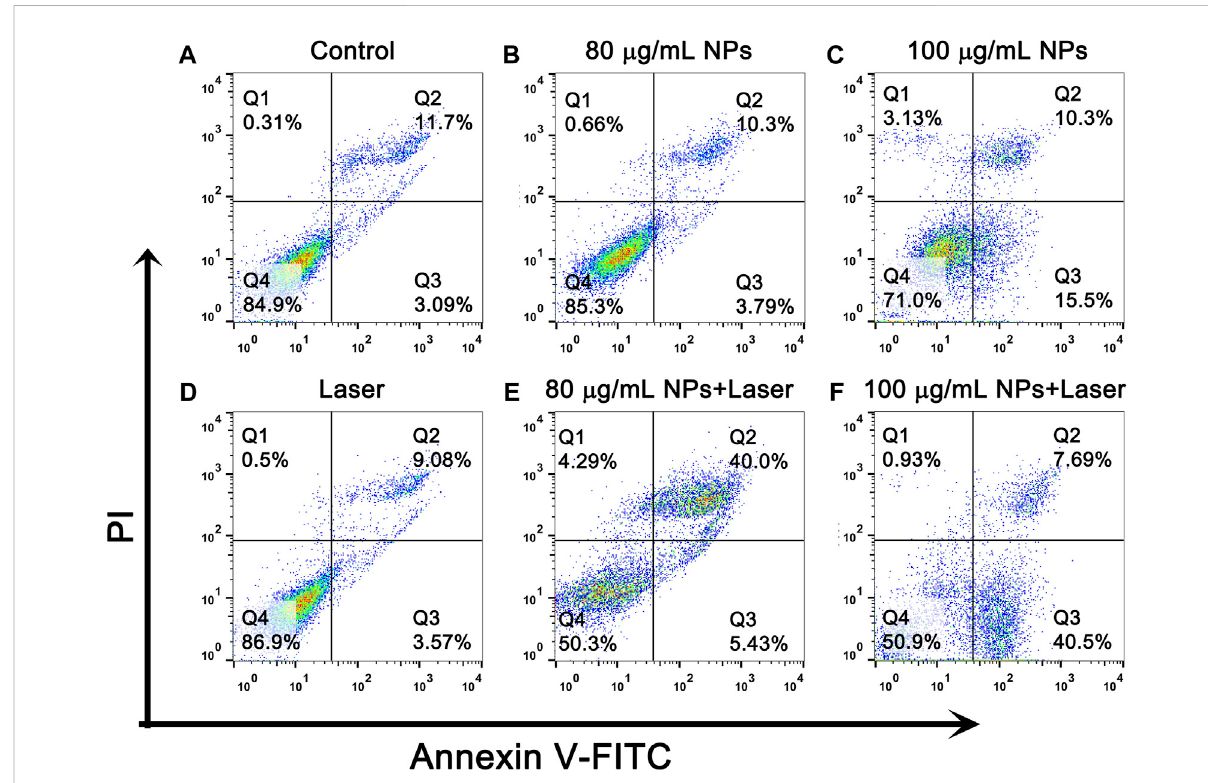
FIGURE 7 Flow cytometry analysis of HeLa cells after treatments with DMEM only (A) , IR820@PDA@PEG NPs only (80 and 100 μ g/mL) (B,C) , laser only (793 nm, 1 W/cm 2 , 8 min) (D) and IR820@PDA@PEG NPs plus laser (793 nm, 1 W/cm 2 , 8 min) (E,F)